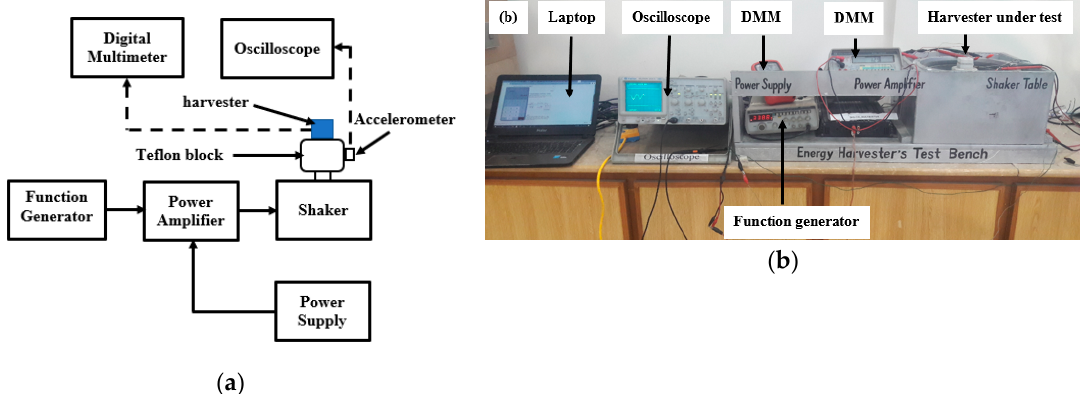
Figure 6. ( a ) Schematic of the experimental rig. ( b ) Developed experimental setup for in-lab characterization of the HIEH.